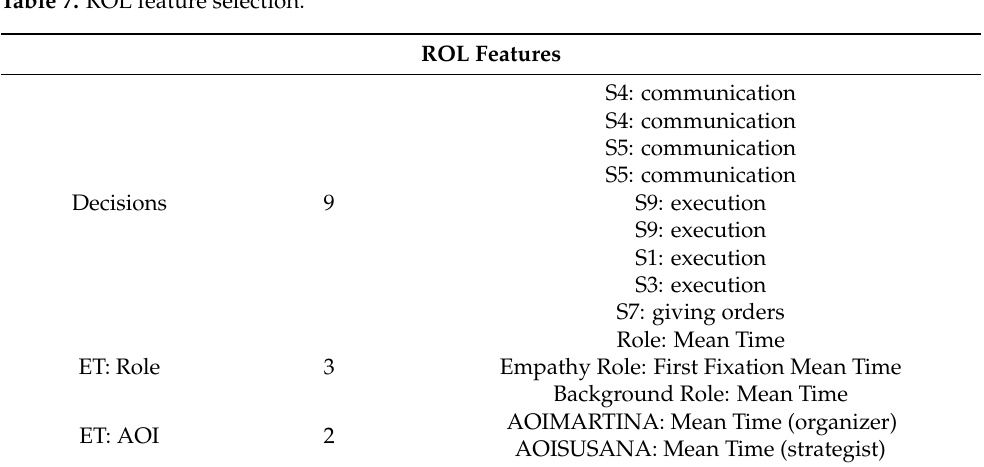
Table 7. ROL feature